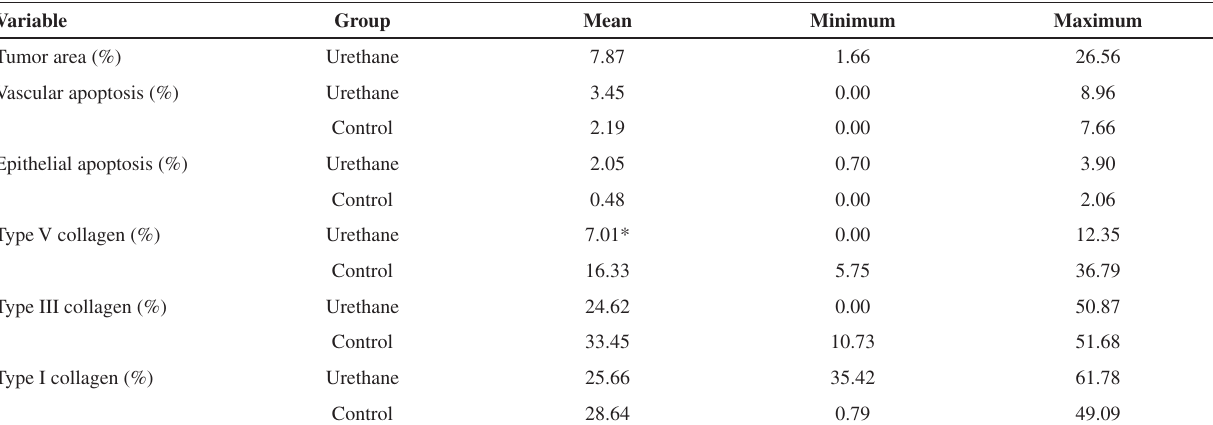
Table 1 - Summary of morphometric results a